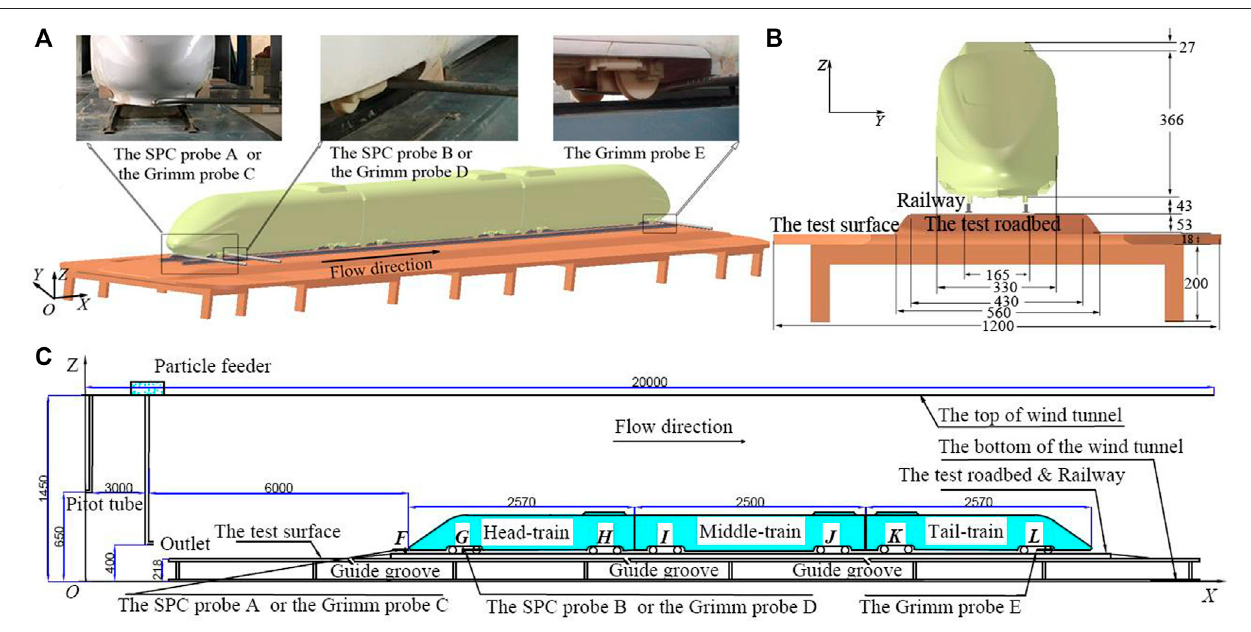
FIGURE2| Sketchofthetrainmodel,including (A) 3 daysdiagram, (B) frontviewofYZplaneinmm,and (C) sideviewofXZplaneinmm( F isreferenceposition, G , H , I , J , K and L represent the central positions of six bogie areas).